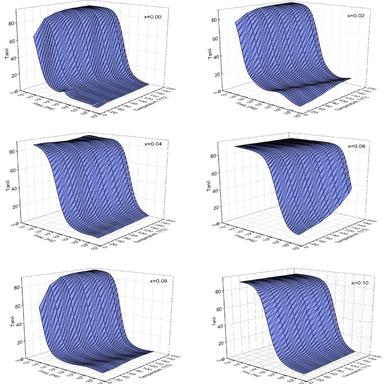
Plots of dielectric loss of NCZFe2-4xSn3xO4 NSFs as functions of frequency and temperature.